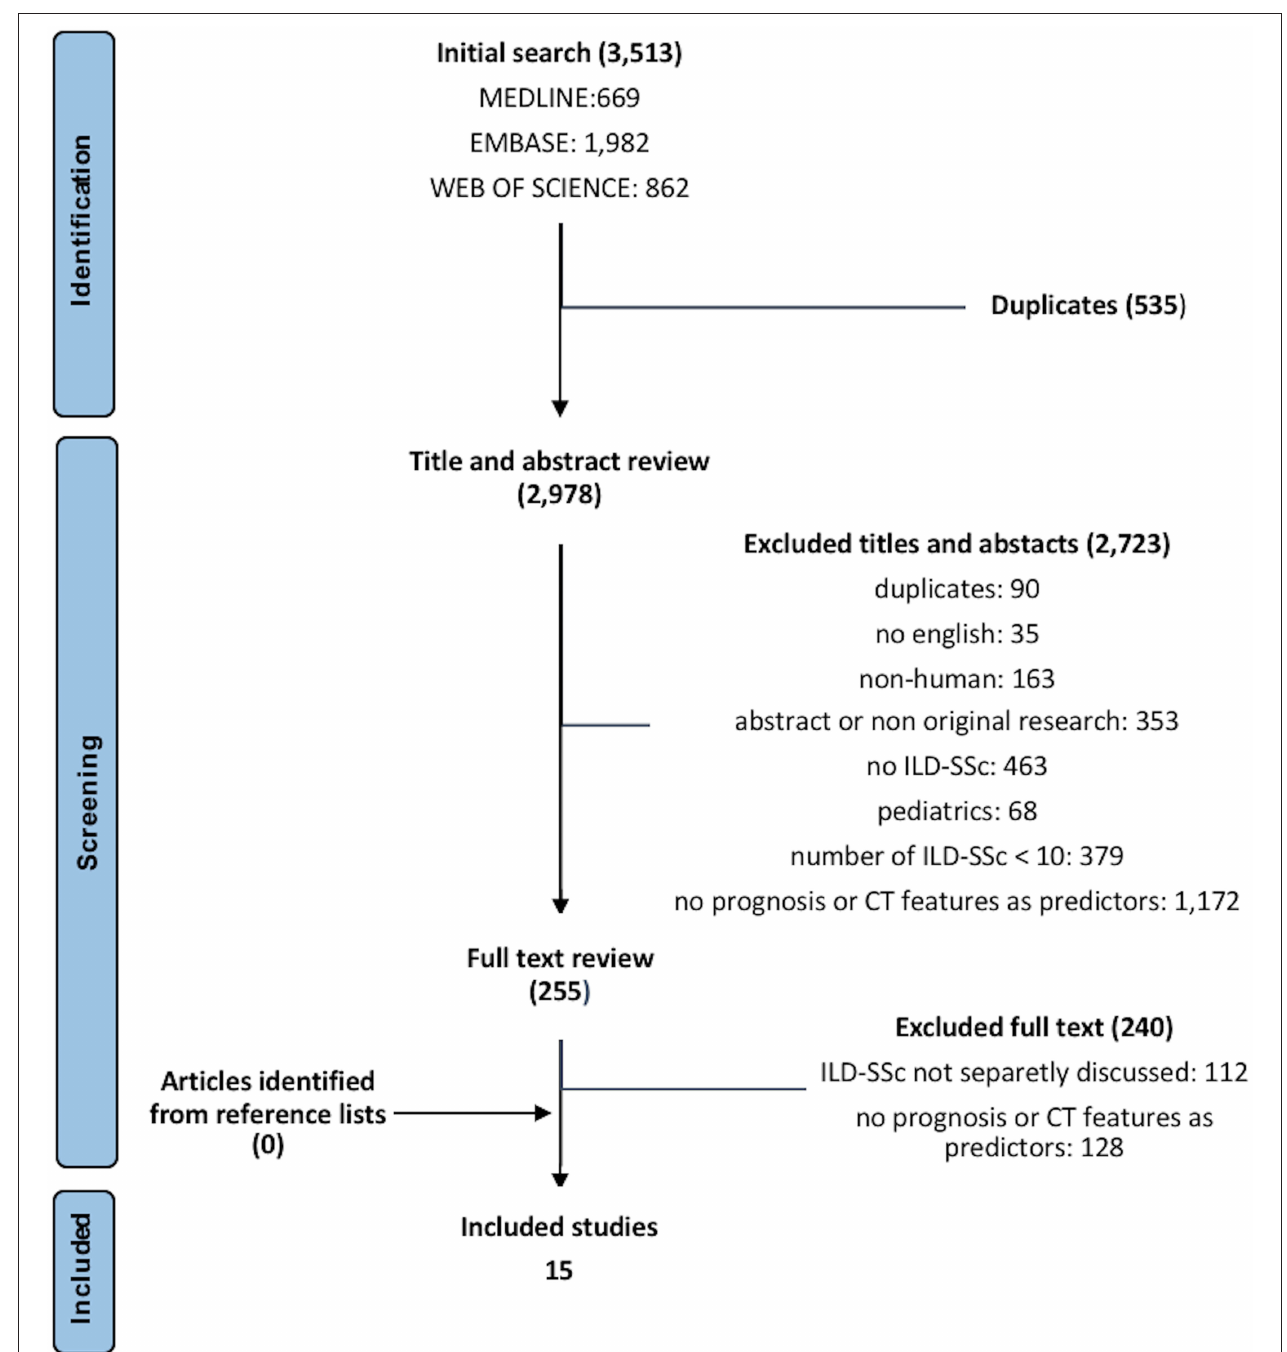
FIGURE 1 | Preferred reporting items for systematic reviews and meta-analyses (PRISMA) diagram of studies’ selection. CT, chest computed tomography; ILD, interstitial lung disease; SSc, systemic sclerosis.